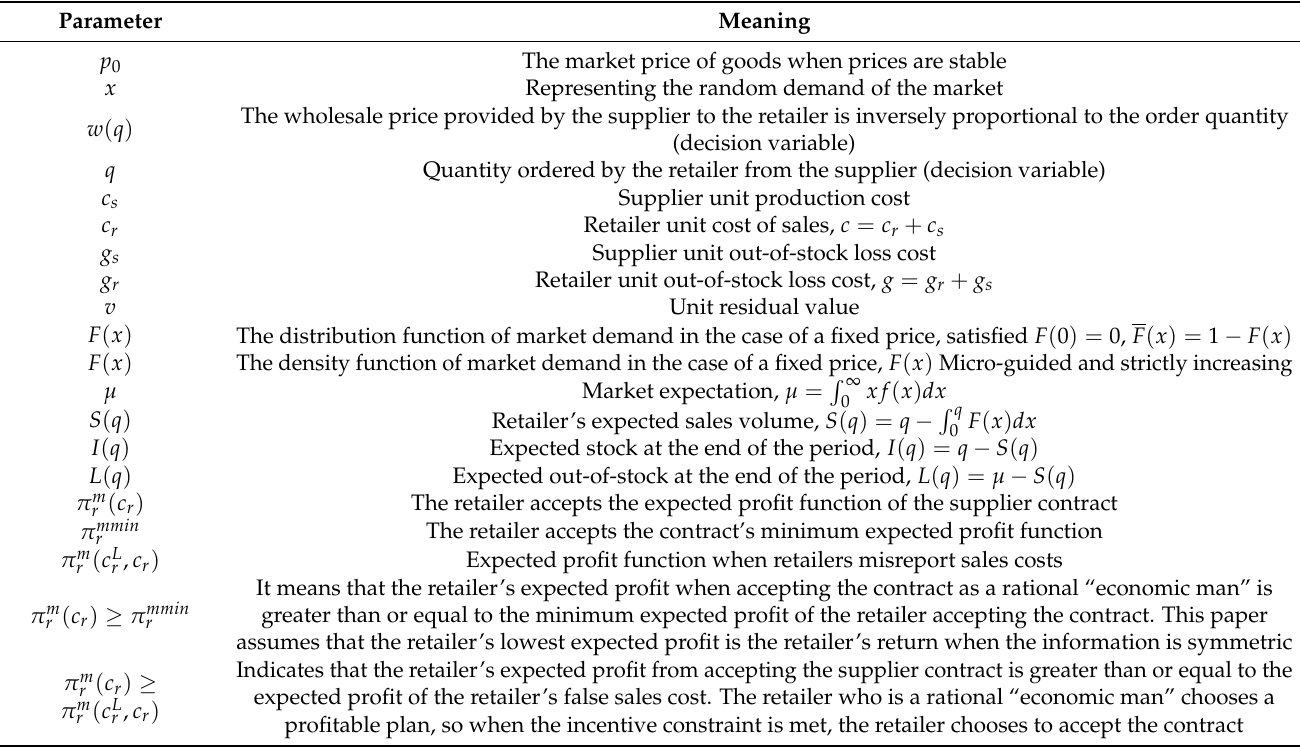
Table 1. List of related